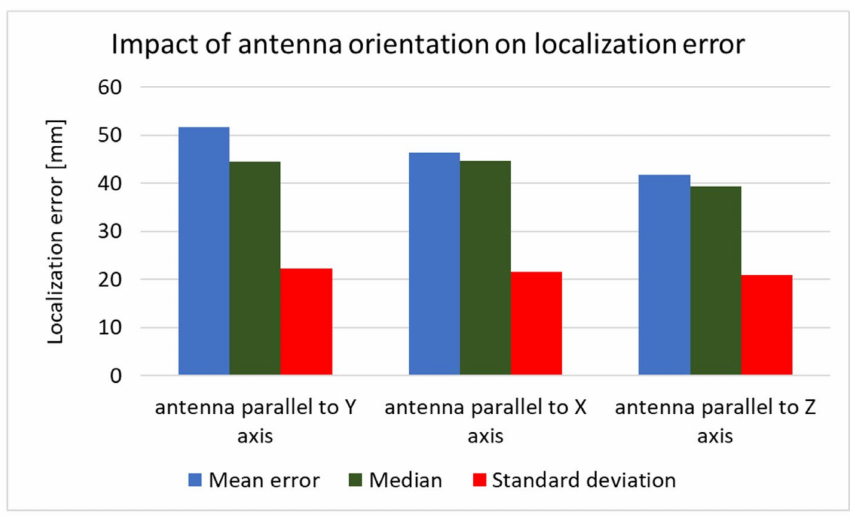
Figure 17. Impact of antenna orientation on localization error obtained in simulation.